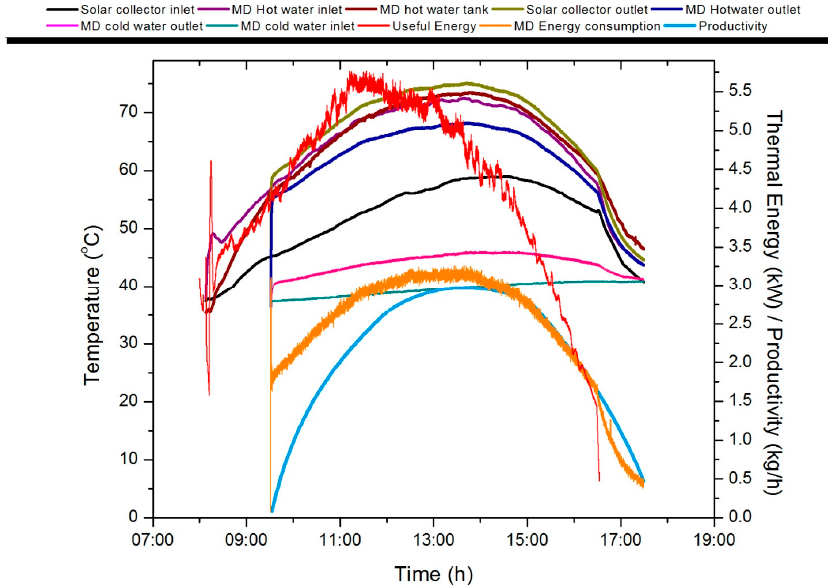
Figure 12. Typical daily operation profile of solar collector field and membrane distillation unit.